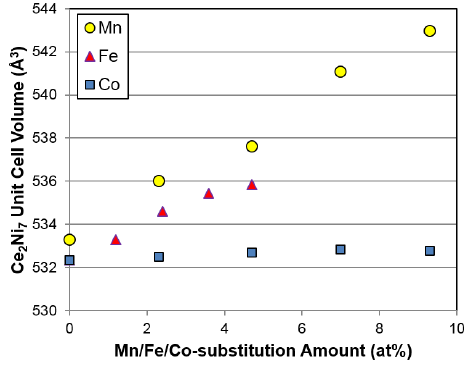
Figure 3. Comparison of Ce 2 Ni 7 unit cell volumes with different substitutions.